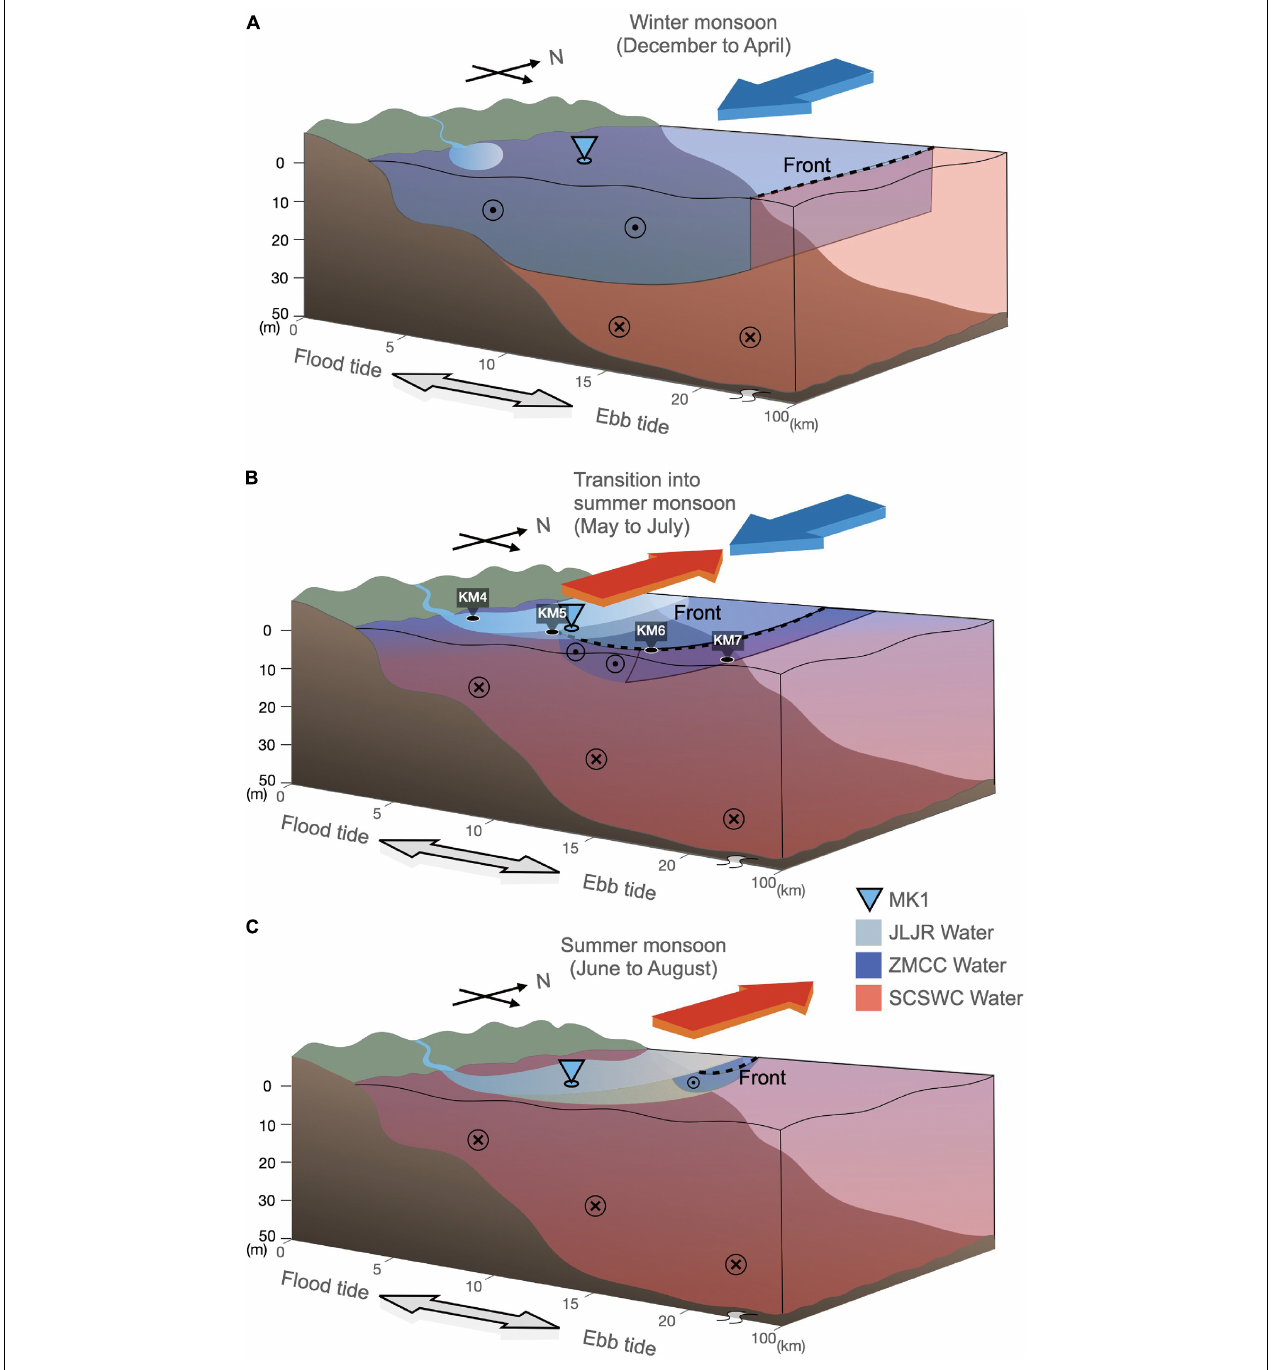
FIGURE 9 | Schematic presentations of how the monsoon regime change affected land-ocean interactions in the western side of the TS. Bold blue and red arrows represent the NE and SW monsoon winds. Flow symbols on the side of each block facing the page show ZMCC coming out of the page (southbound) and SCSWC going into the page (northbound). Translucent red and blue color blocks represent SCSWC and ZMCC water masses and the solid light blue represents JLJR water, respectively. The inverse triangle shows the location of MK1 station. The black dotted line marks the approximate location of the SST front between ZMCC and SCSWC. (A) Under NE monsoon dominance in winter, ZMCC water occupies the upper water column, the SCSWC water is in deeper layer and is seaward of the ZMCC water. (B) In the transitional period of the regime change in spring, the ZMCC water recedes northward and shoreward and begin to mix with the encroaching SCSWC water from the south and from below. The dispersal of the effluent of JLJR parallels the front between the ZMCC and SCSWC. (C) Under SW monsoon dominance in summer, SCSWC water almost occupies the entire nearshore water column. River plume water replaces the ZMCC water at the surface near the coast. Traces of ZMCC water can still be